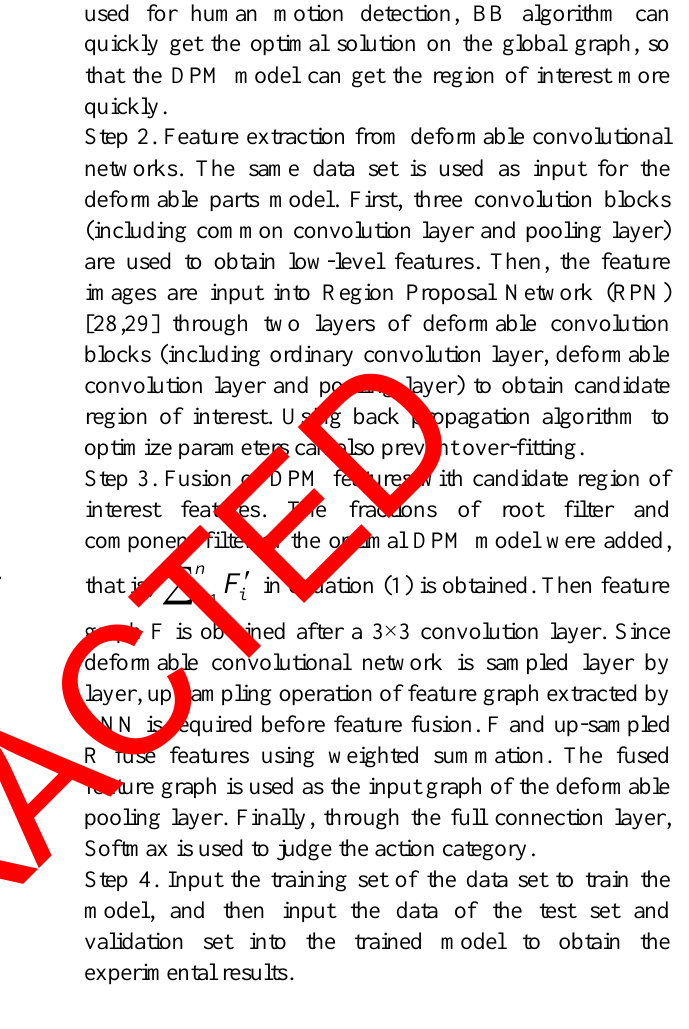
Figure 6. Deep networks module of